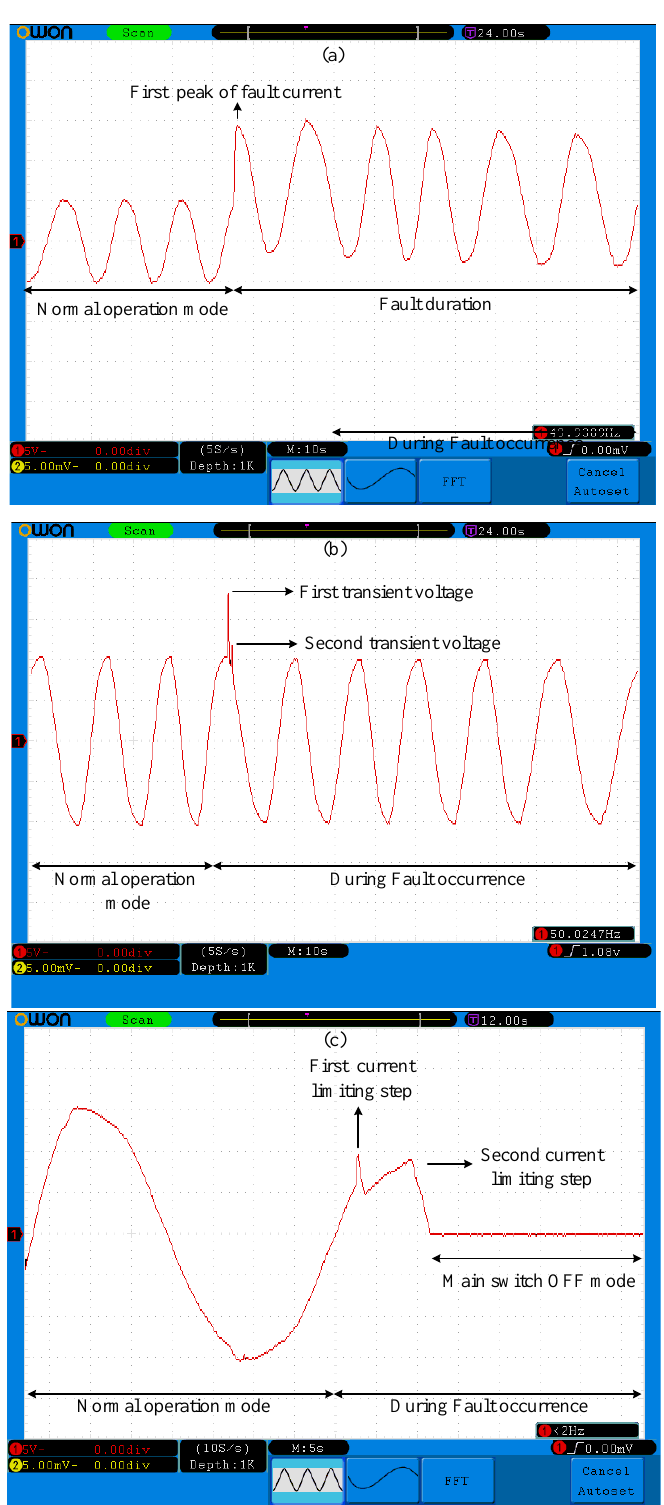
Figure 10. ( a ) Line current during normal and fault condition, ( b ) PCC voltage during normal and fault condition, and ( c ) main switch current during normal and fault condition.